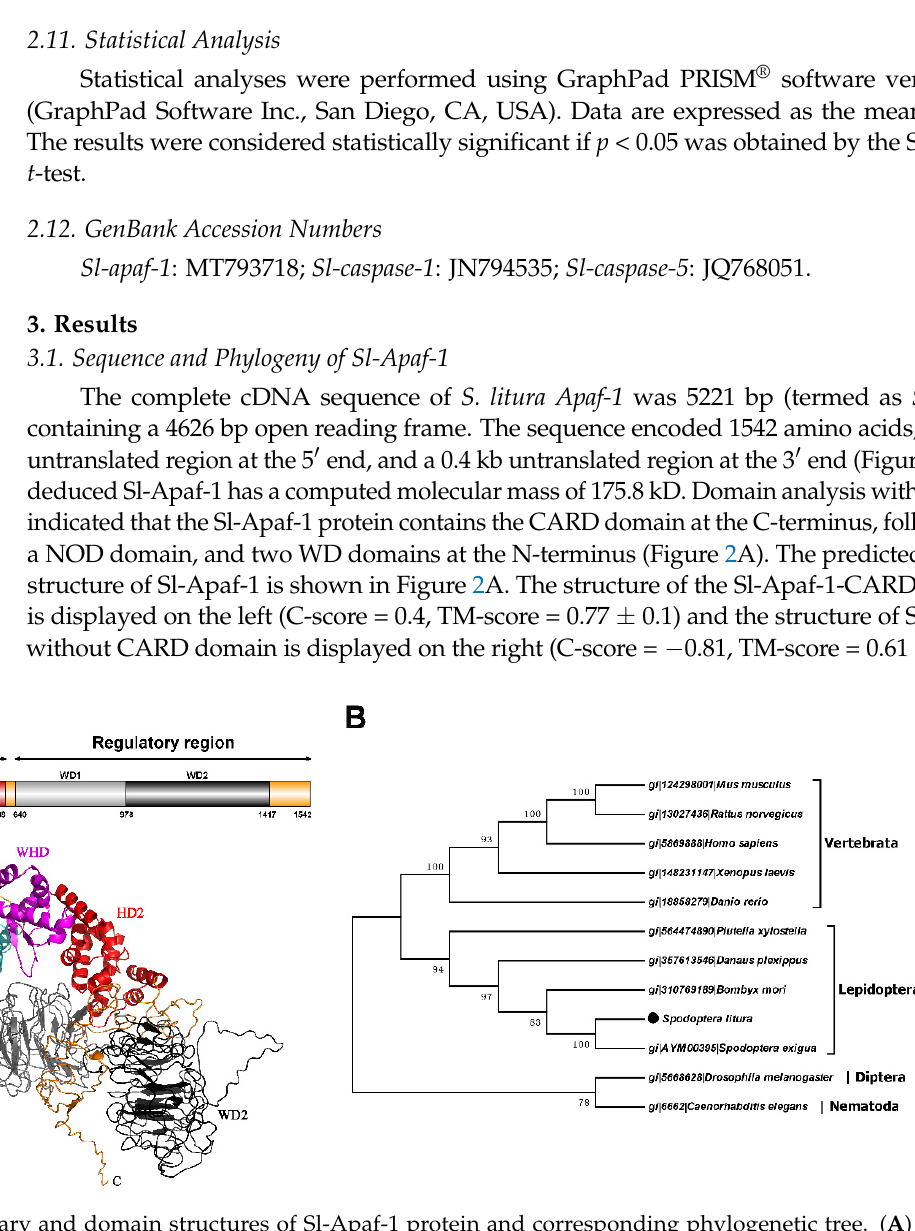
Figure 2. Predicted tertiary and domain structures of Sl-Apaf-1 protein and corresponding phylogenetic tree. ( A ) is a schematic representation and prediction of the tertiary structure of the Sl-Apaf-1 protein. Subdomains are color coded, and linkers are shown in orange. I-Tasser was used to predict the tertiary structures of the putative Apaf-1 protein, the first of model was the most accurate and was therefore used for analysis. ( B ) Evolutionary tree of the Apaf-1 protein based on the neighbor-joining method with MEGA 7.0.21 software.